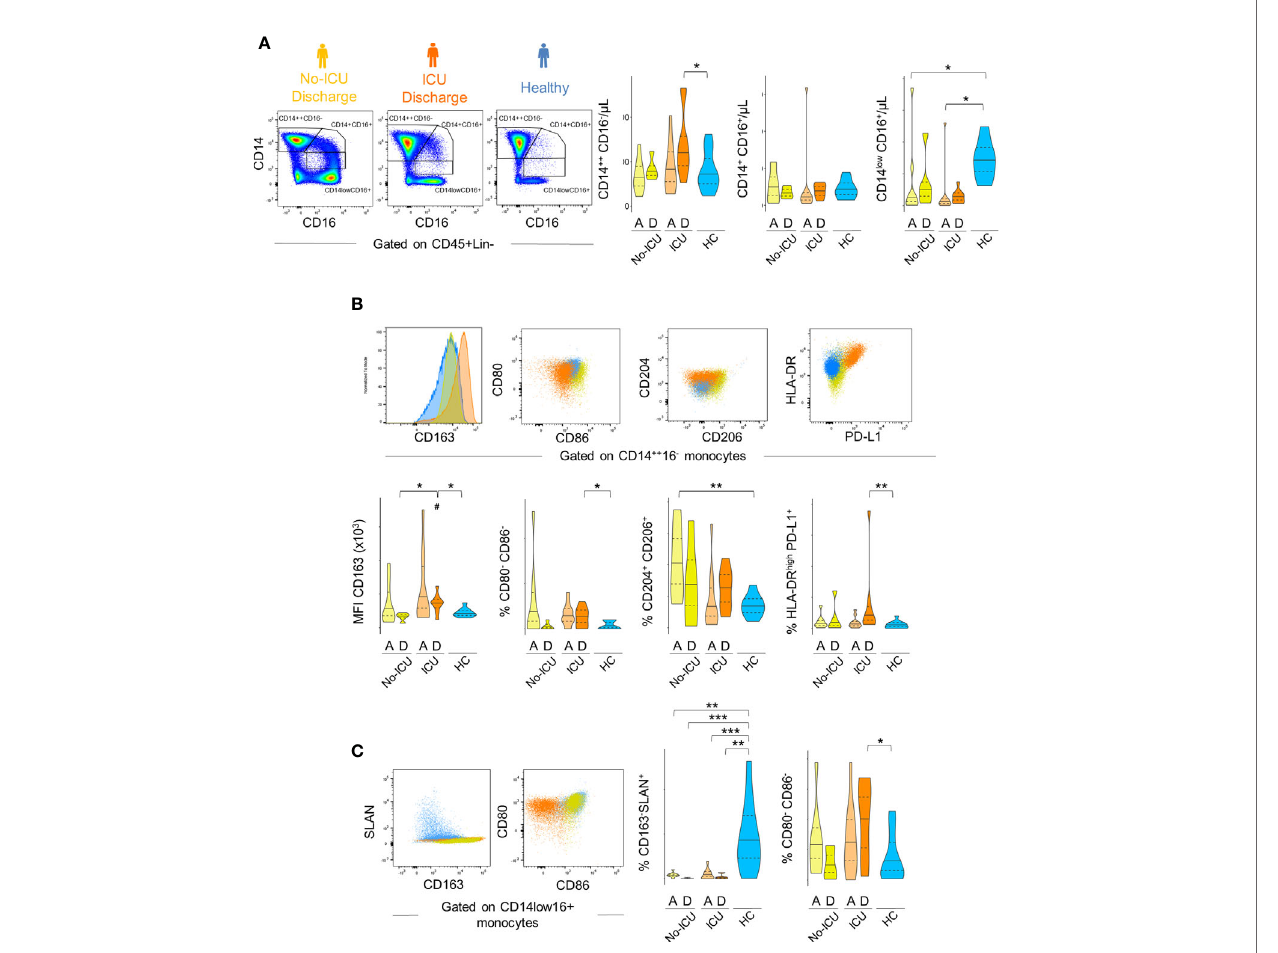
FIGURE 3 | Immune regulatory phenotype of monocytes in severe COVID-19 assessed by bi-dimensional hierarchical gating strategy. (A – C) Illustrative dot plots of the analysis performed in a representative No-ICU patient at discharge (yellow) and in an ICU patient at discharge (orange), as well as in a healthy control (blue) are shown; (A) Violin graphs show absolute counts of the main monocyte subsets; (B) CD163 MFI and proportion of CD80 − CD86 − , CD204 + CD206 + , and HLA- DR high PD-L1 + subsets within classical (CD14 ++ CD16 − ) monocytes; (C) Proportion of CD163 − Slan + and CD80 − CD86 − within non-classical (CD14 low CD16 + ) monocytes. There were no signi fi cant differences between admission and discharge in both ICU and No-ICU patient groups (Wilcoxon matched-pairs signed rank test). Other comparisons were done using Mann – Whitney U-test and signi fi cant P values are shown: ***p < 0,001; **p < 0,01; *p < 0,05 , as compared to healthy; # p < 0,05 , as compared to No-ICU at the same